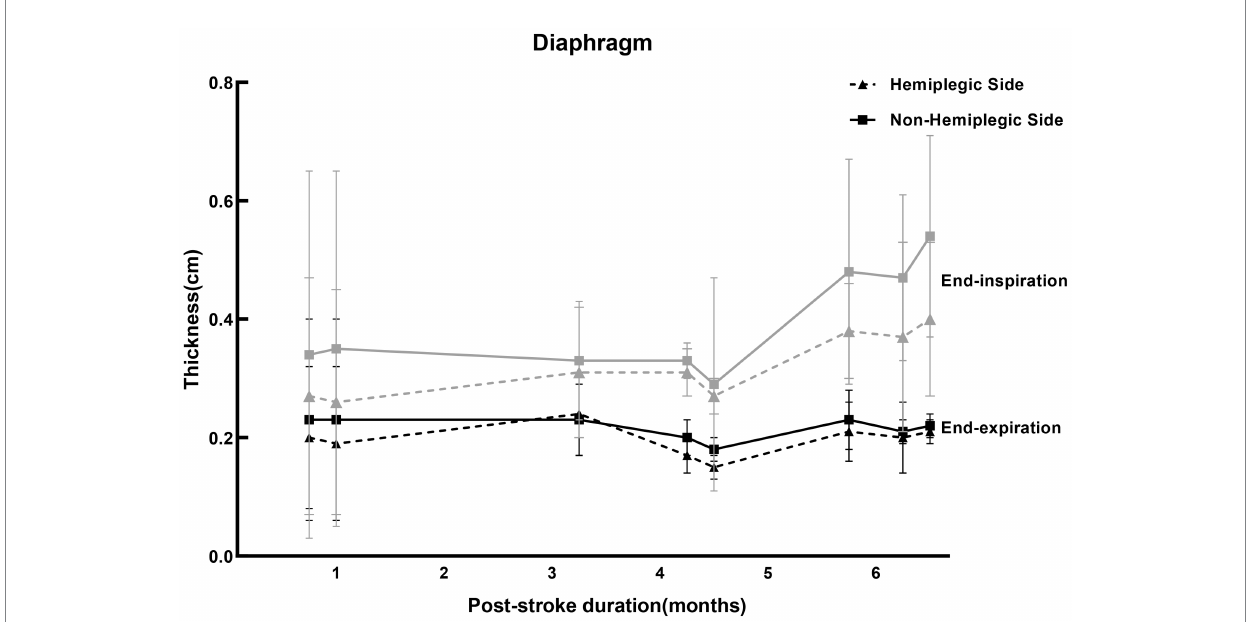
FIGURE 2 Studies for the thickness of the diaphragm ultrasound in stroke patients. The reference values of the diaphragm thickness of the stroke patients at the subacute stage at end-expiration and end-inspiration measured by ultrasound in different studies in Supplementary material 2, presented by the mean ± standard deviation. Where the gray curves (solid and dotted lines) represented the diaphragm thickness at the end of inspiration, and the black curves (solid and dotted lines) were the thickness of the diaphragm at the end of expiration. The solid lines were the thickness of the diaphragm on non- hemiplegic side, while the dotted lines were the hemiplegic side. The values on the abscissa represented the average duration of post-stroke (months).